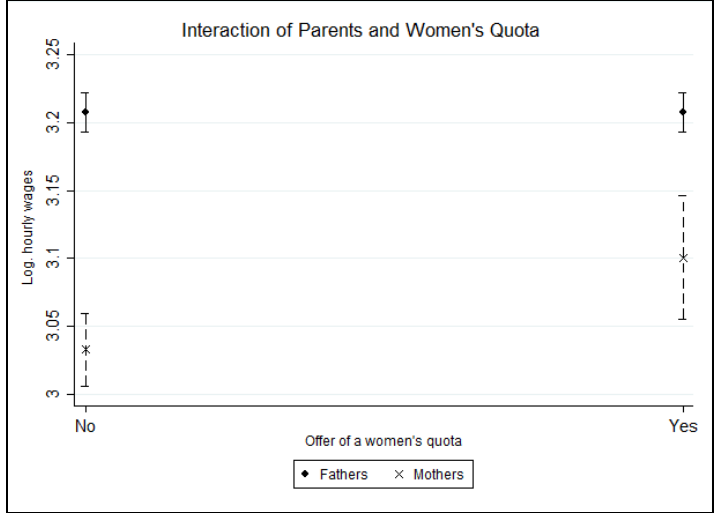
Figure A1. Log. hourly wages of fathers and mothers within establishments with and without a women’s quota (predictive margins of parents with 95% CIs using Stata 14; based on Table 3).